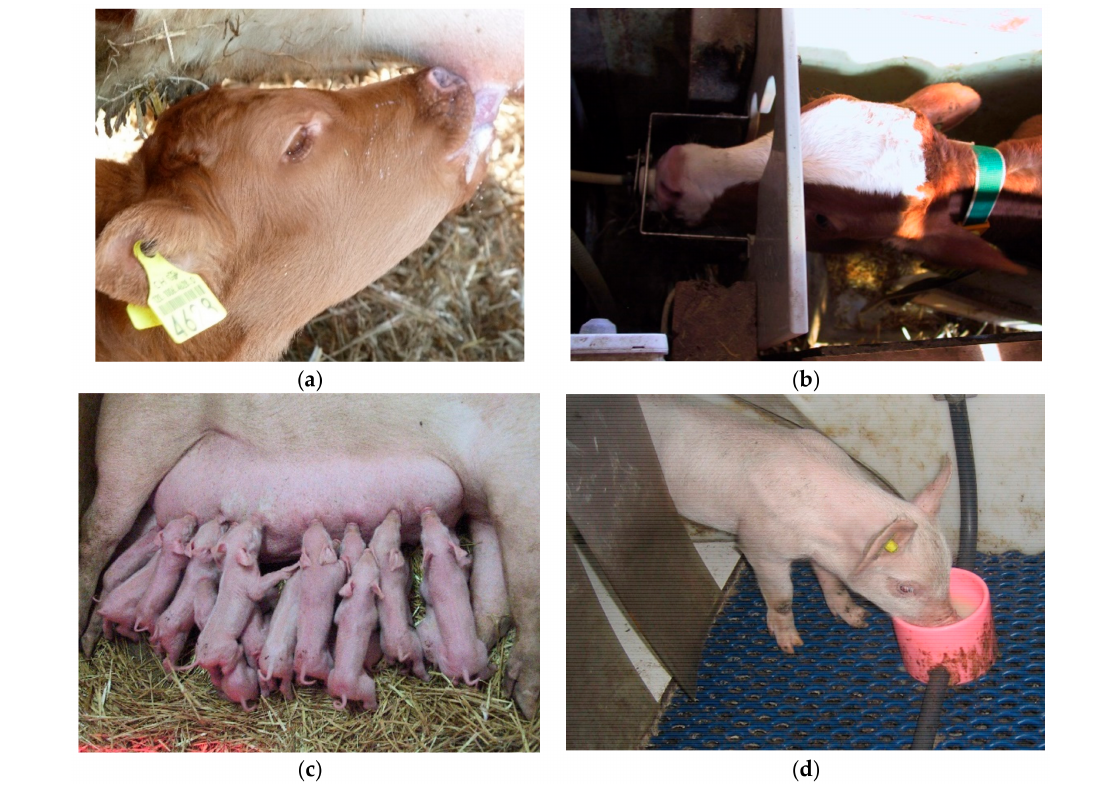
Figure 1. Milk feeding in calves ( a , b ) and piglets ( c , d ), either from the udder ( a , c ) or artificially ( b , d